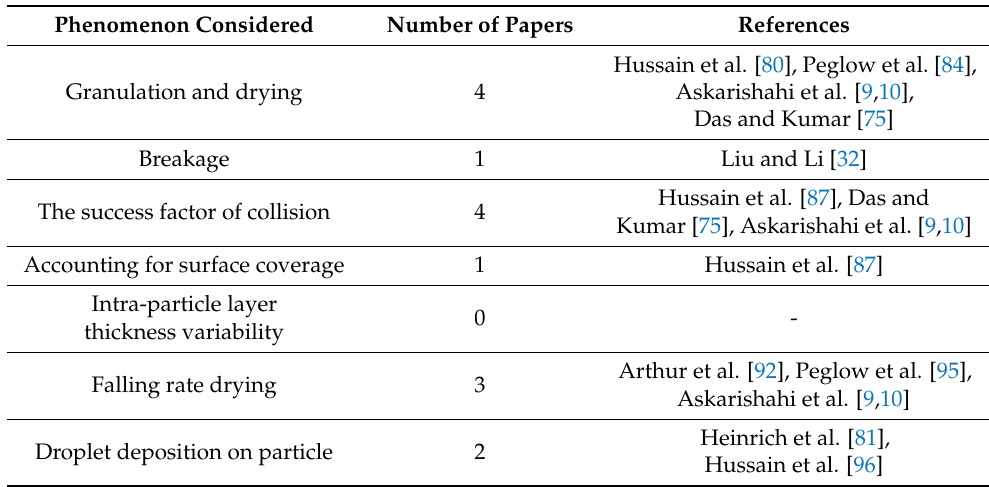
Table 5. Phenomena involved in the fluid bed granulation which need to be addressed in compart- mental modeling